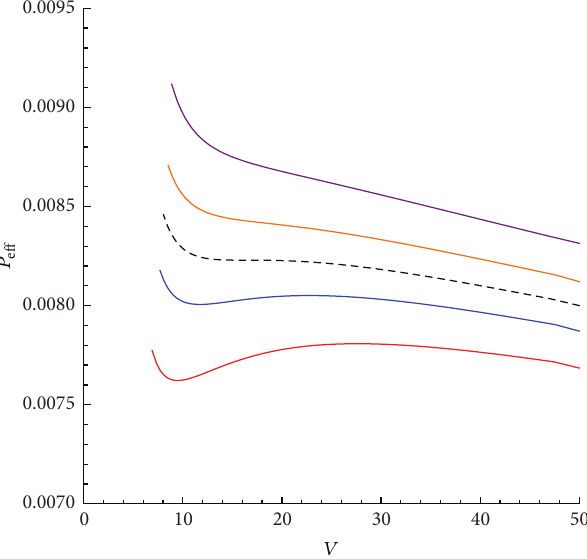
Figure 1: 𝑃 - 𝑉 (here 𝑉 is the thermodynamic volume) diagram of eff charged GB-dS black hole with 𝑄 = 1 , 𝑑 = 5 , ̃𝛼 = 0.1 , and 𝑇 𝑐 = 0.028628